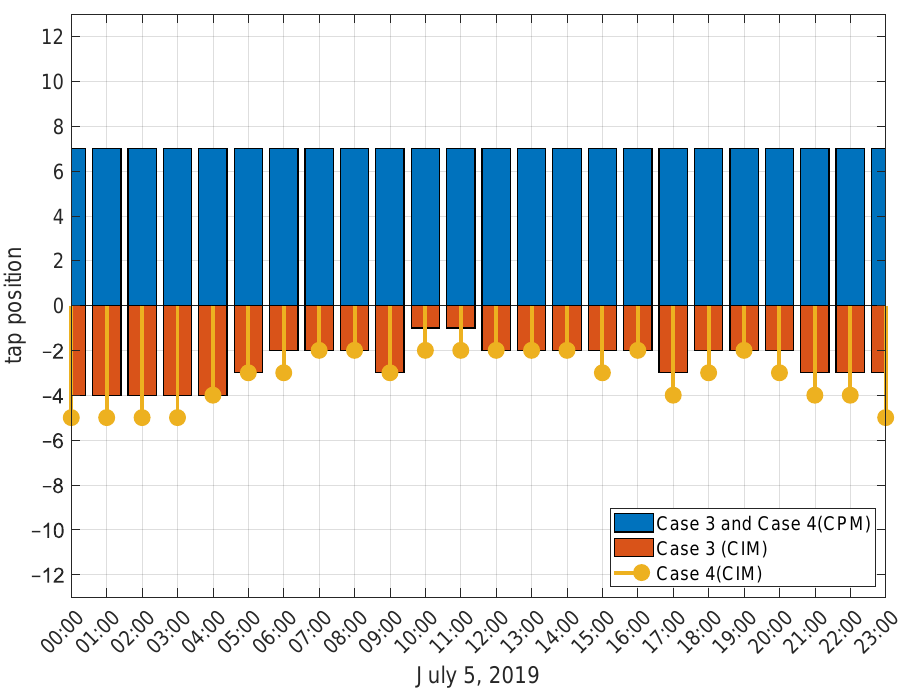
Figure 9. Optimal tap positions for different simulation scenarios and loading